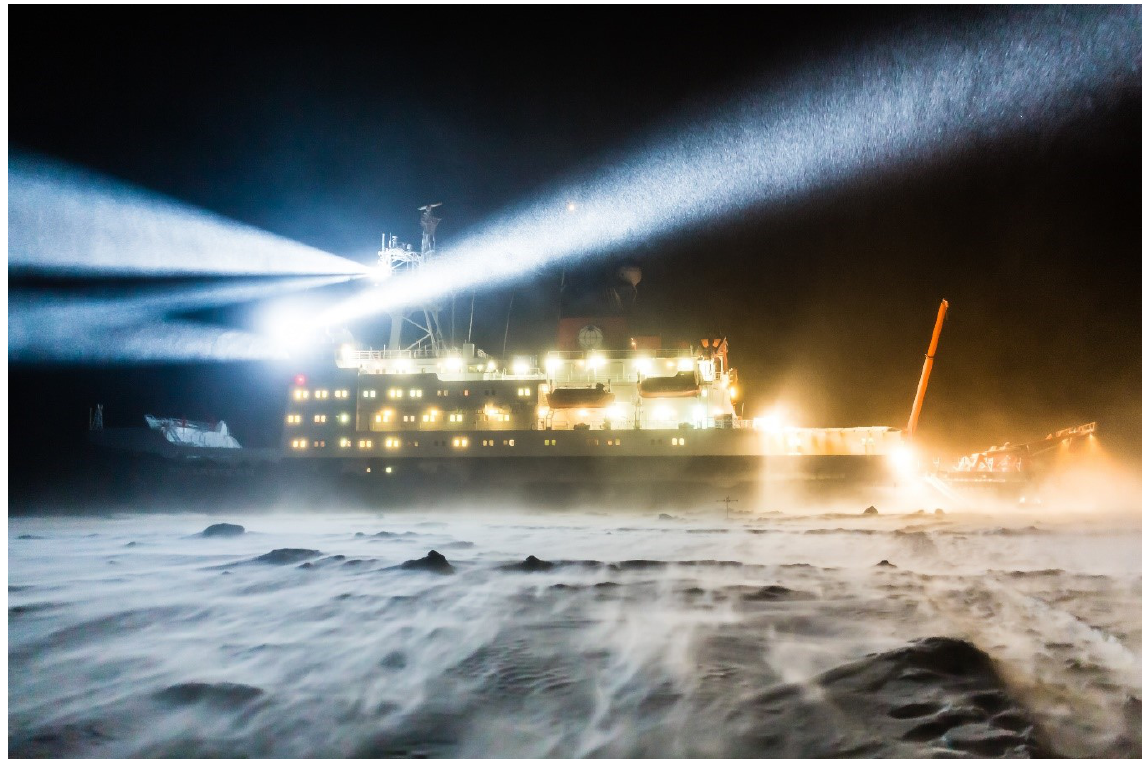
Figure 3: Polarstern during the winter experiment in the Weddell Sea (Antarctica). Photo: AWI / S.